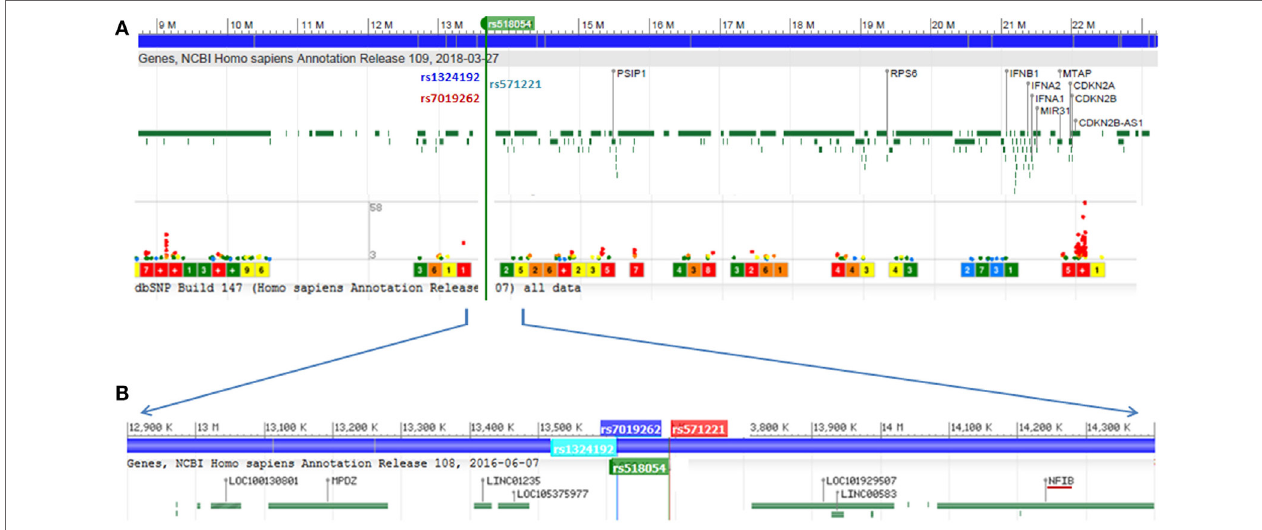
FigUre 2 | (a) Genome wide association study hotspot locus of 9p21-23 region screened in this study. Frailty-associated SNPs are marked in rsIDs, and lower dots indicate disease-associated SNPs in this region and level of significance. (b) Localized view of associated SNPs showing its location between LOC105375977 and LINC00583 (C9orf146). NFIB is the nearest well-characterized gene to SNP rs518054. Genomic region data adapted from NCBI dbSNP